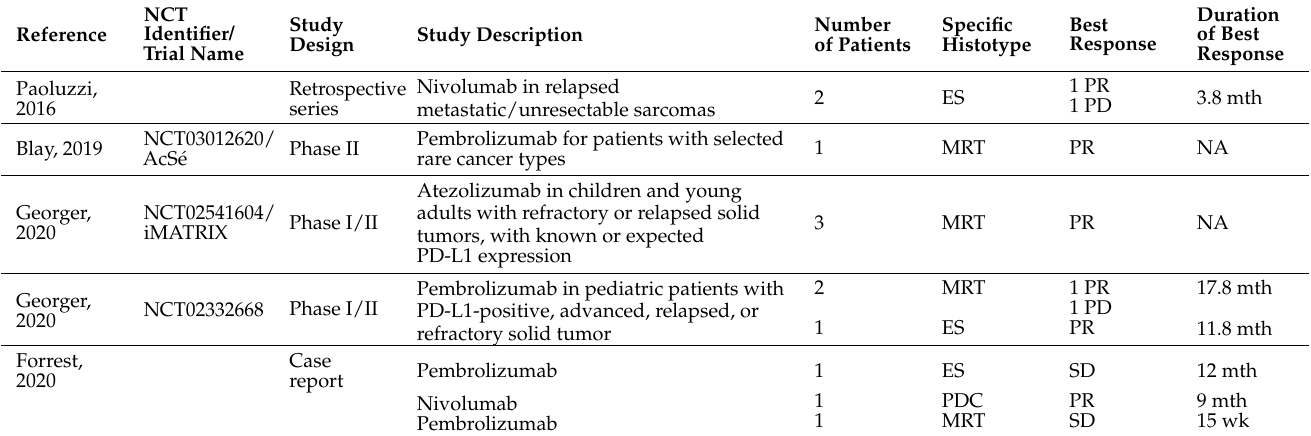
Table 2. Results of clinical studies evaluating ICI in monotherapy in SMARCB1-deficient sarcoma.